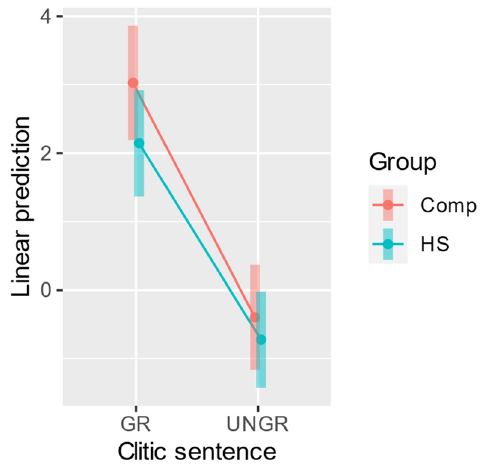
Figure 1. Group by item interaction.